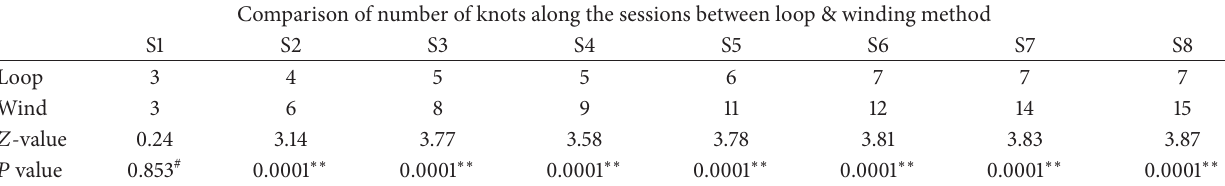
Table 1: Comparison of average number of knots was done between groups A and B (decimal number converted to whole number). Comparison of number of knots along the sessions between loop & winding method